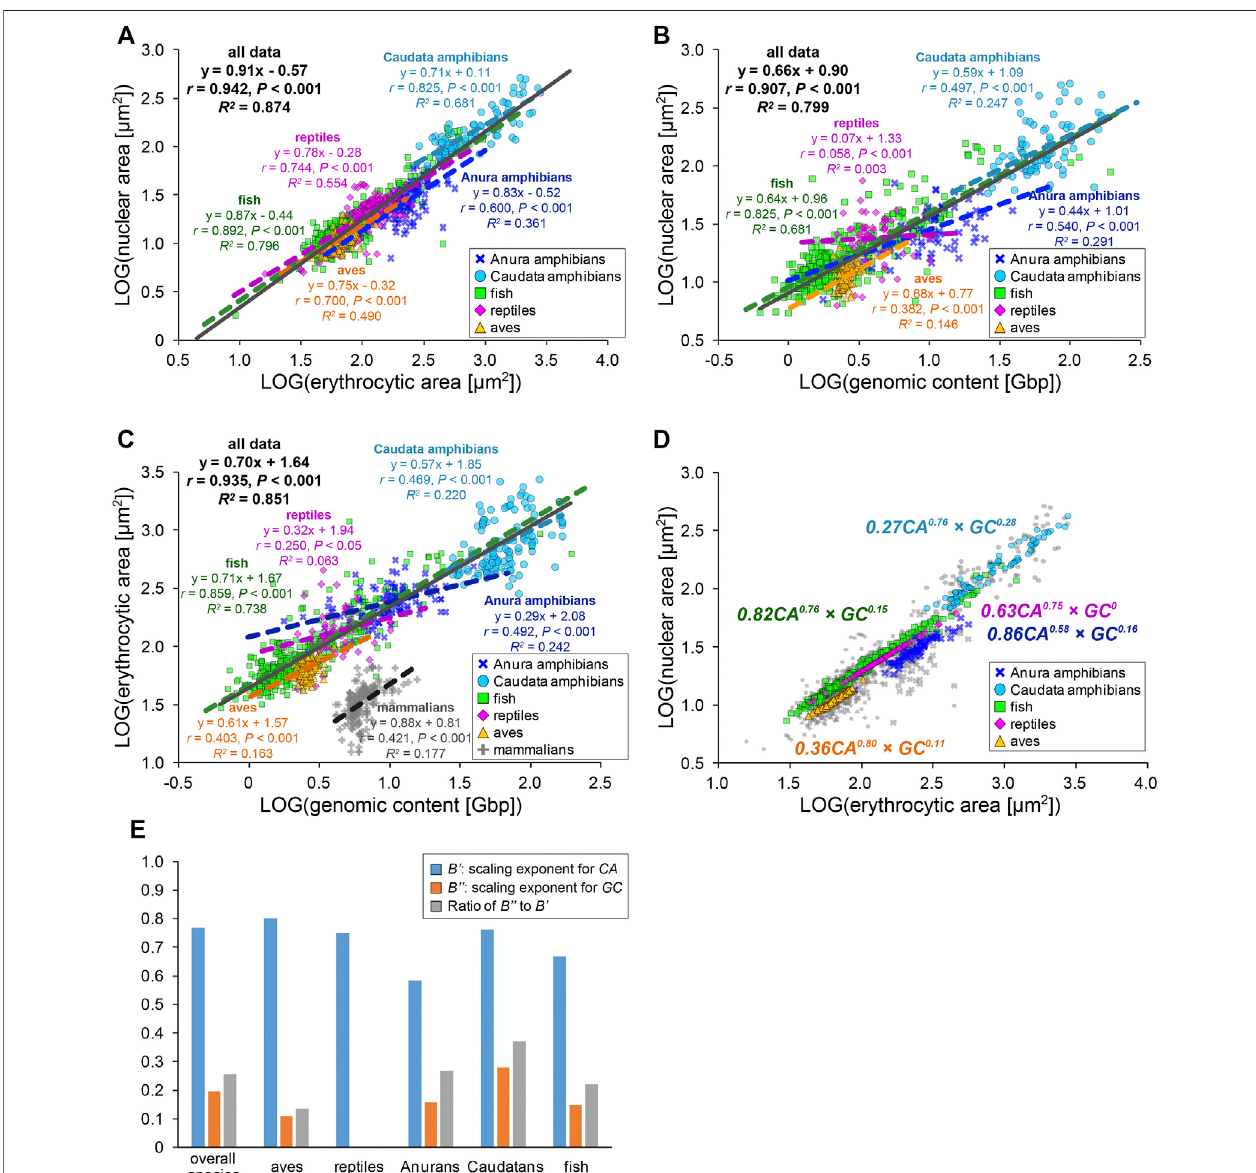
FIGURE 4 | Inter-species relationship among nuclear area, erythrocytic area, and genomic content in different species classes. (A) Collected nuclear cross- sectional areas were plotted against erythrocyte cross-sectional areas in a log-log plot. The equations for the regression line, Pearson ’ s correlation ( r ), P values, and the coef fi cientofdetermination( R 2 )havebeenindicatedfordatasetsofeachspeciesclass(colored)orallspeciestogether(gray).DatafromAnuraamphibians(blue, n =93), Caudata amphibians (light blue, n = 88), fi sh (green, n = 354), reptiles (purple, n = 157), and aves (yellow, n = 270) have been shown. (B) Collected nuclear and (C) erythrocytic cross-sectional areas have been plotted against the genomic contents in a log-log plot. The dataset of enucleated erythrocytes from mammalian species have also beenplotted(gray).Anura amphibians: n =71 (B) , n =105 (C) ;Caudata amphibians: n =86 (B) , n =122 (C) ; fi sh: n =336 (B) , n =383 (C) ;reptiles: n =62 (B) , n = 64 (C) ; aves: n = 124 (B) , n = 186 (C) ; and mammalians: n = 204 (C) . (D) Nuclear cross-sectional areas estimated from the equation with two scaling exponents, for erythrocytic cross-sectional area CA and genomic content GC , have been shown using colored symbols. Gray symbols are identical to the collected dataset shown in (A) .Thescalingexponentsestimatedusingtheequationsforeachspeciesclasshavebeenshownintheplot. (E) Estimatedvaluesofthescalingexponentsfor CA (blue), GC (orange), and ratios of the scaling exponent for CA to that for GC (gray) in each dataset of species class and that for all species together.